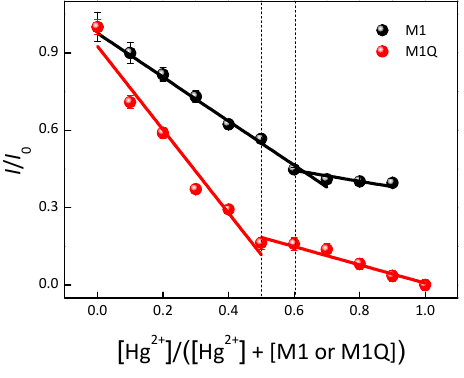
Figure 3. Titration curves and dissociation constants of M1 in CH 3 CN/water and M1Q in water.